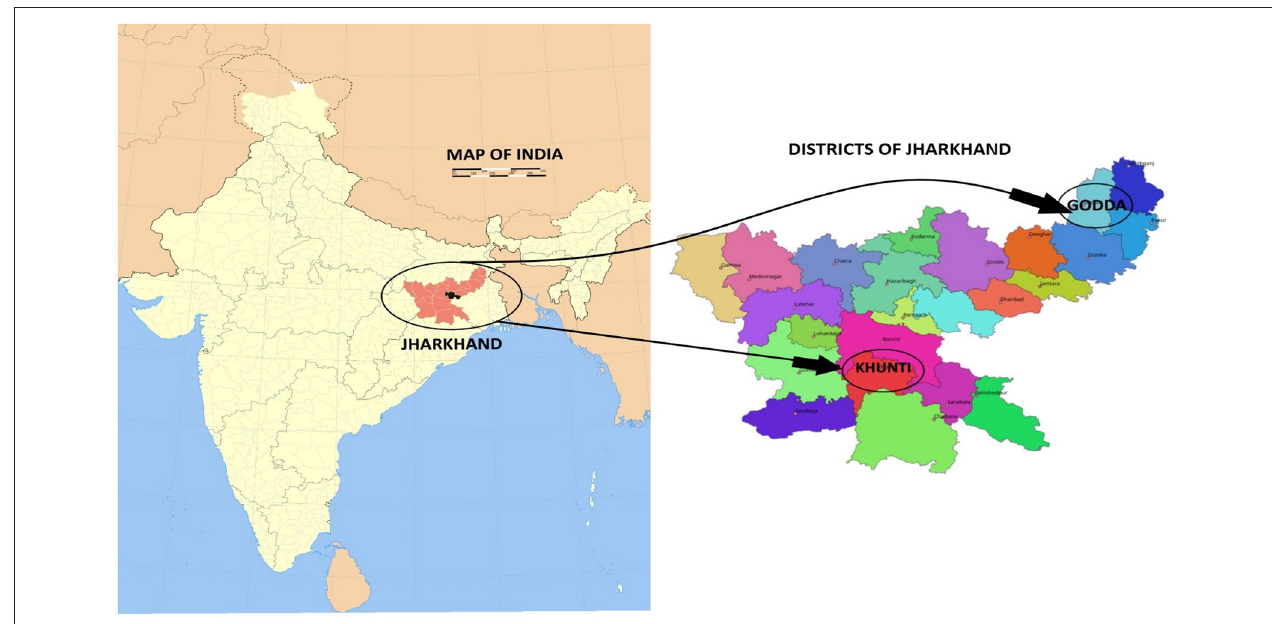
FIGURE 1 | Selection of study districts in